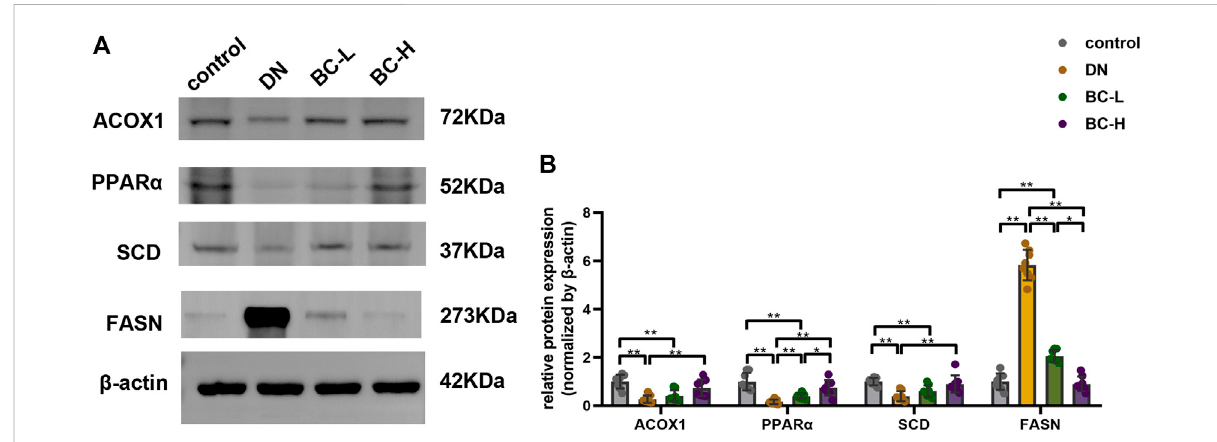
FIGURE 10 Effect of Bailing Capsule treatment on the relative protein expression levels of ACOX1, PPAR α , SCD and FASN in kidneys of rats shown by westernblot. (A) RepresentativeimmunoblotsofACOX1,PPAR α ,SCD,andFASNinkidneysofratsamongdifferentgroups.Westernblotshowedthat Bailing Capsule increased the protein levels of ACOX1, PPAR α , SCD and inhibited the protein levels of FASN in DN rats. (B) Quanti fi cation of immunoblots of ACOX1, PPAR α , SCD, and FASN. DN, diabetic nephropathy; BC-L, low dosage of Bailing Capsule; BC-H, high dosage of Bailing Capsule. Data are expressed as mean ± SD ( n = 8). * p < 0.05 and ** p <